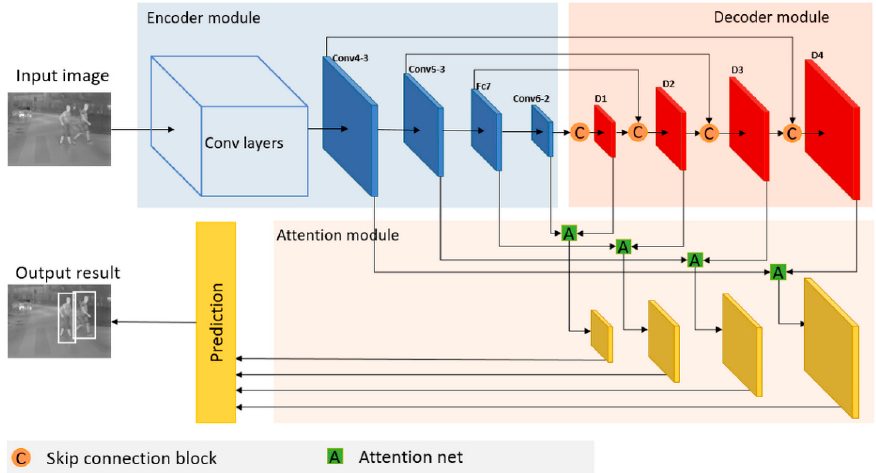
Figure 1. Architecture of the proposed attention-guided encoder-decoder convolutional neural network (AED-CNN).